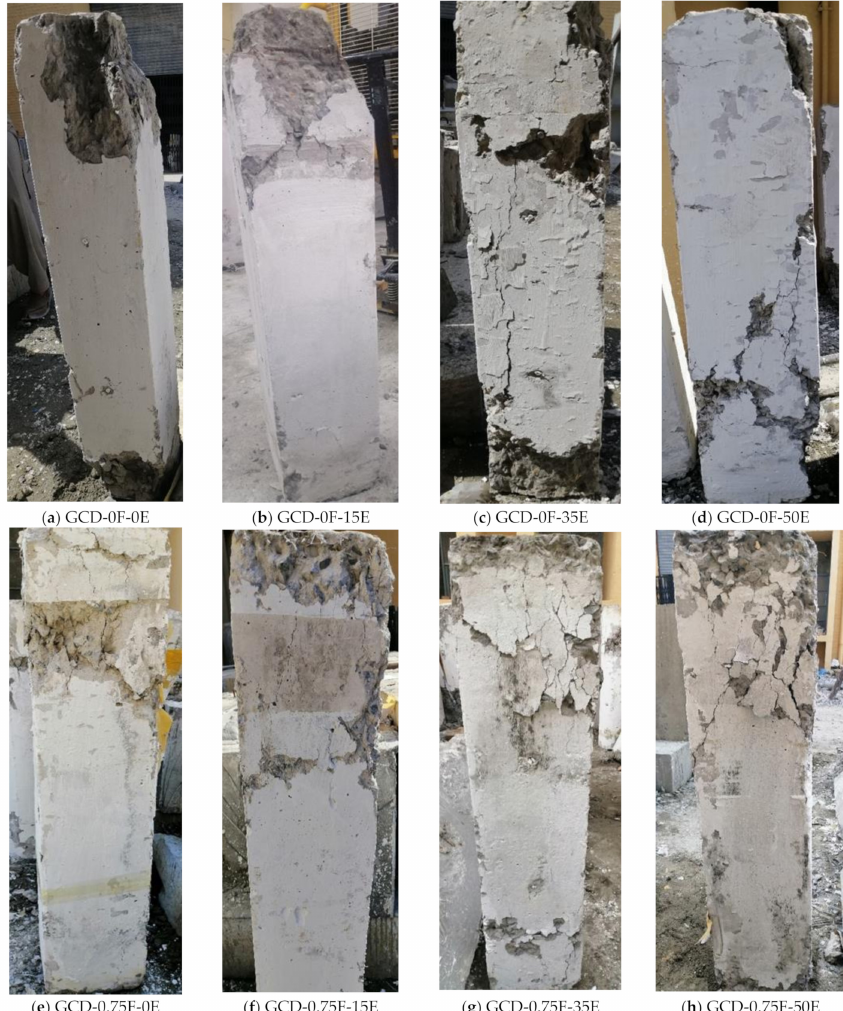
Figure 8. The failure mode of GCD columns after the test.